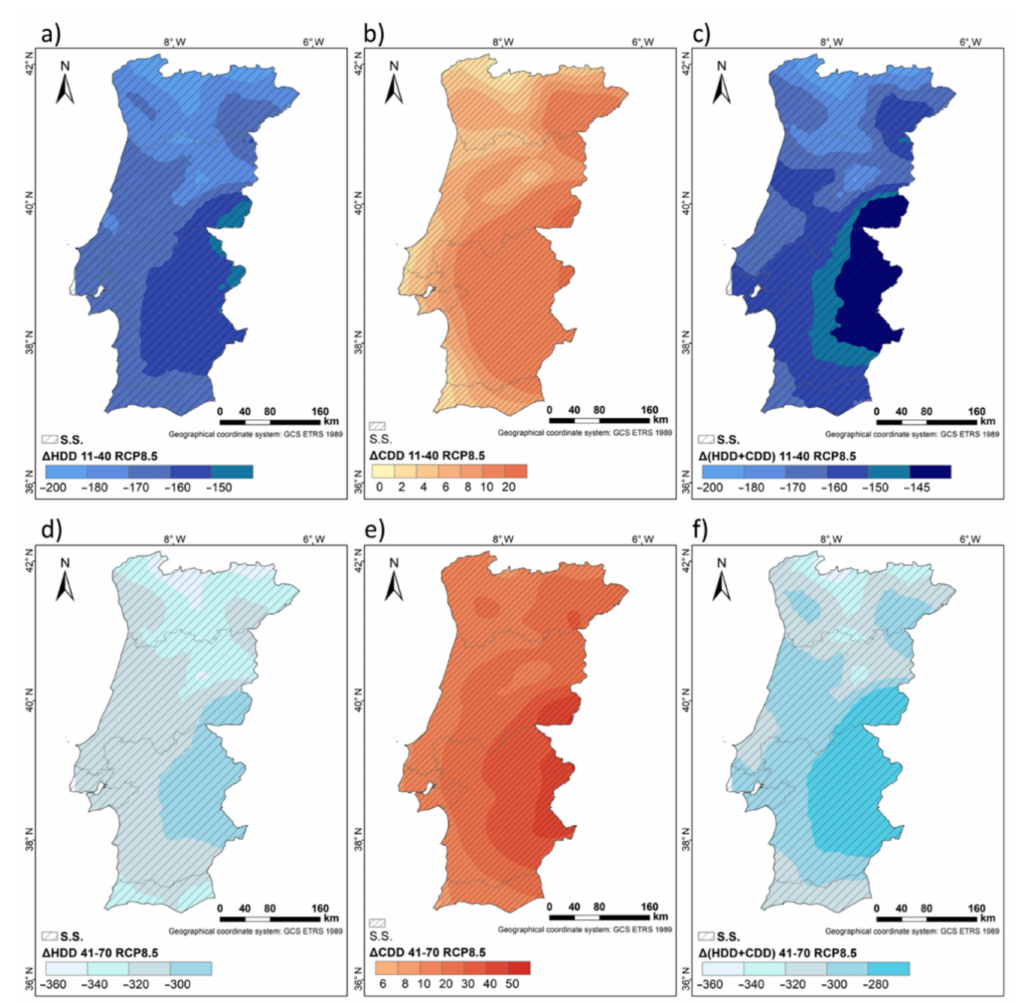
Figure 7. Statistically significant (S.S.) anomalies ( ∆ ) in ◦ C × D per year at a 5% significance level for ( a , d ) HDD, ( b , e ) CDD, and ( c , f ) HDD + CDD between 2011–2040 (upper) and 2041–2070 (lower) under RCP8.5. (Note that ∆ = future period –